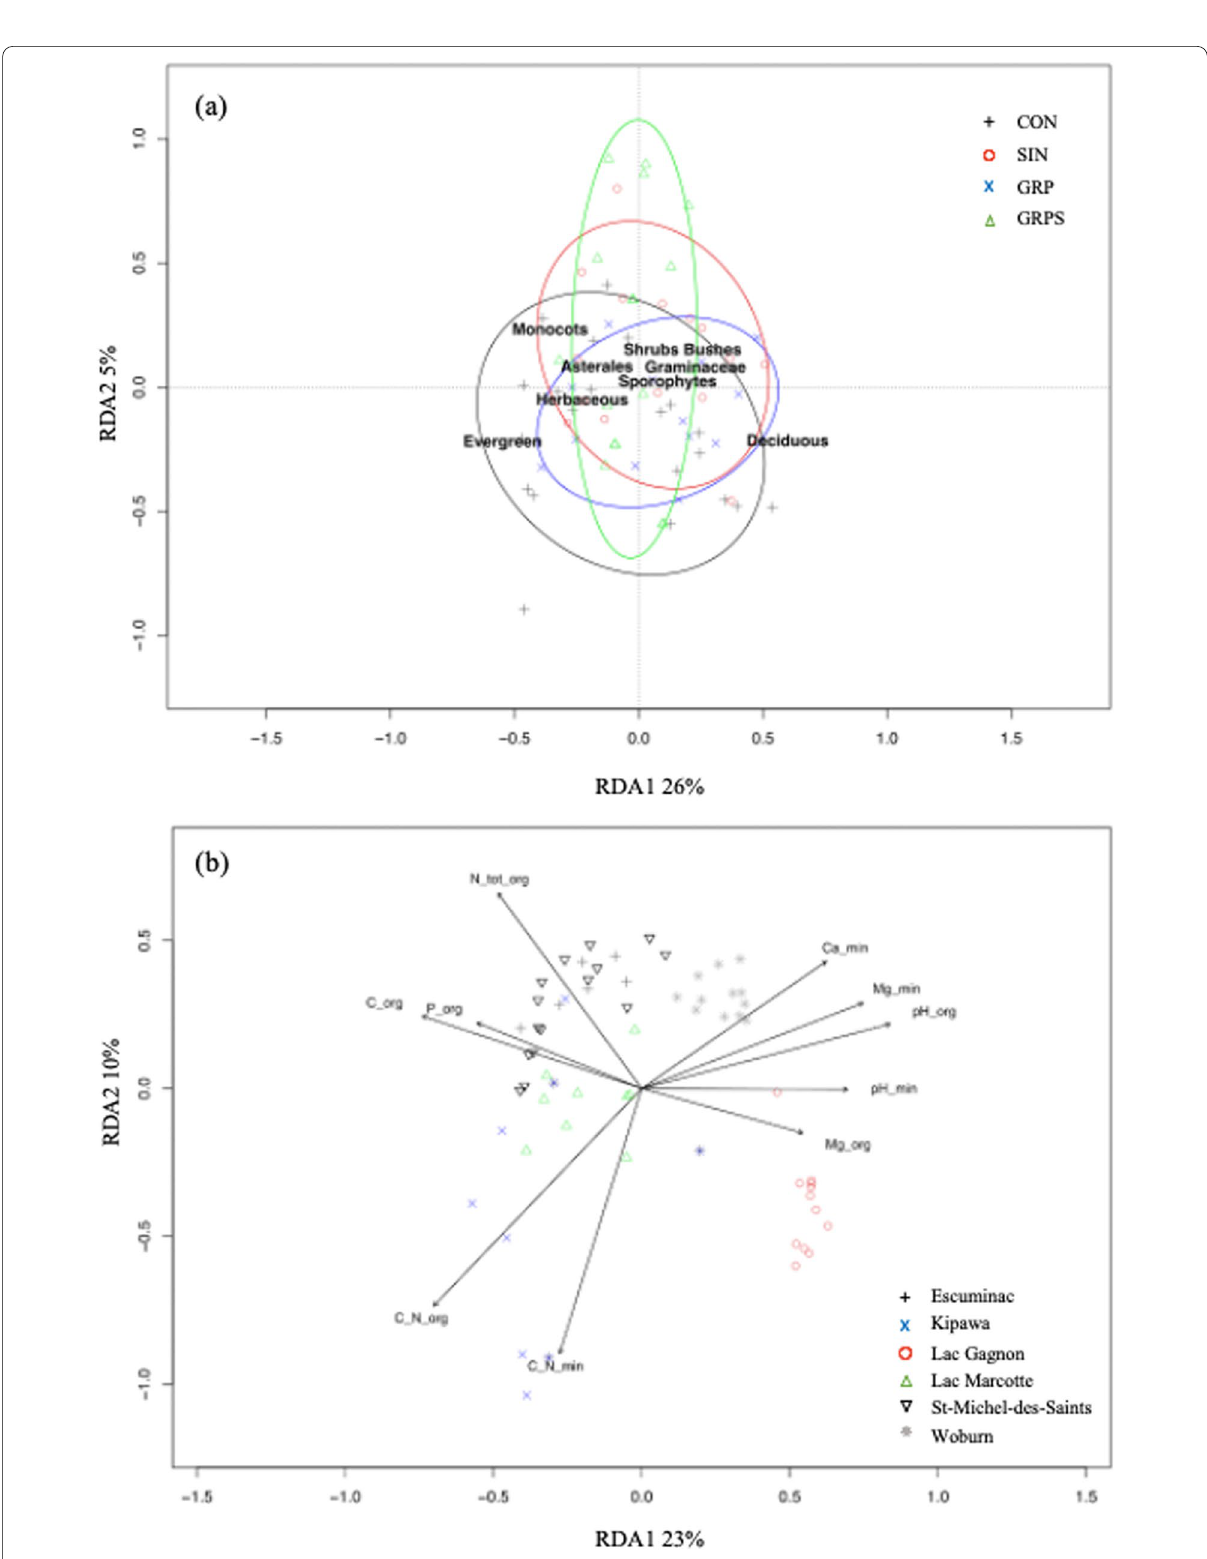
Fig. 2 (See legend on previous